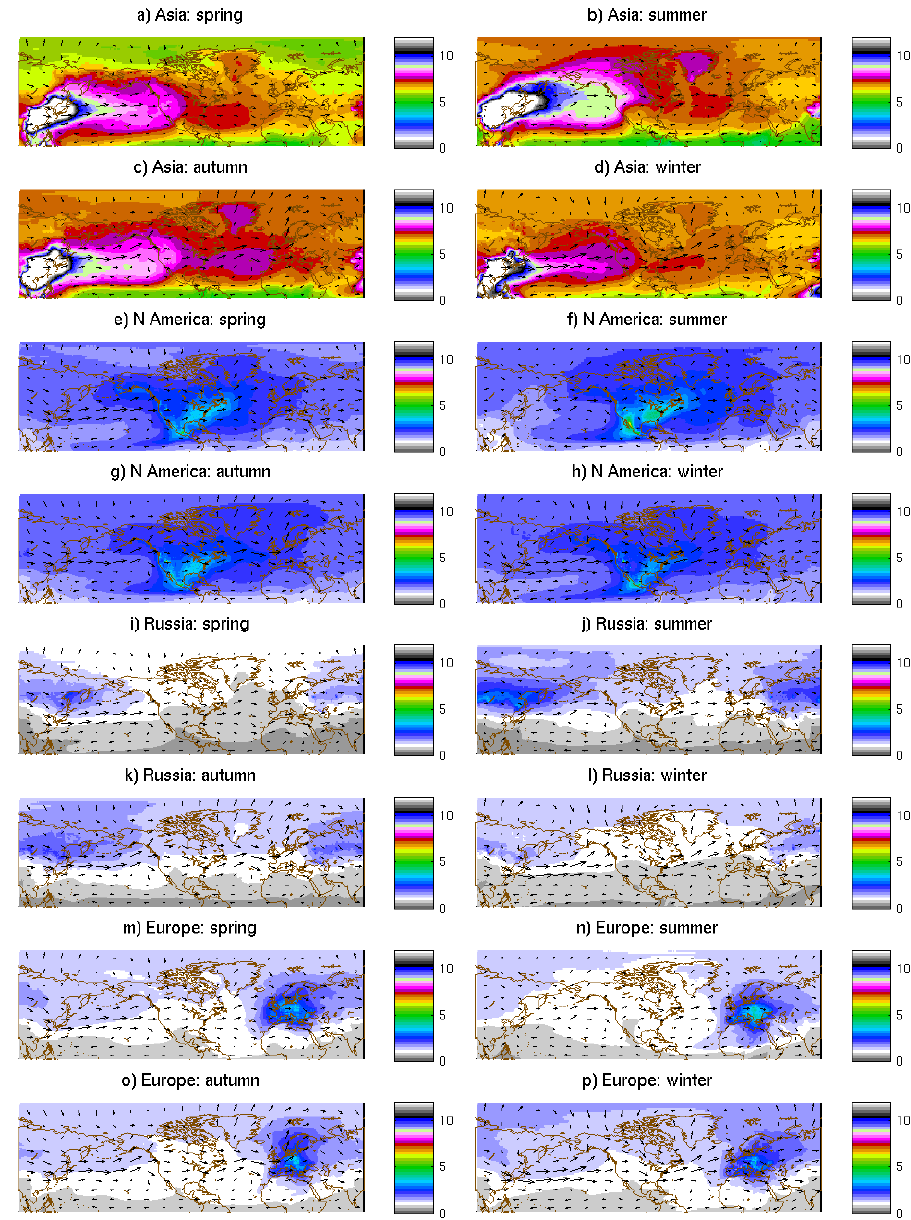
Fig. 8. Plotted for each source region and season for the year 2000 are: i) the GEM column burden (ngm − 3 ) from the surface to 0.516 sigma ( ≈ 523hPa; shading interval of 0.3ngm − 3 ) , and ii) average wind directions and relative strengths calculated using winds from 925 to